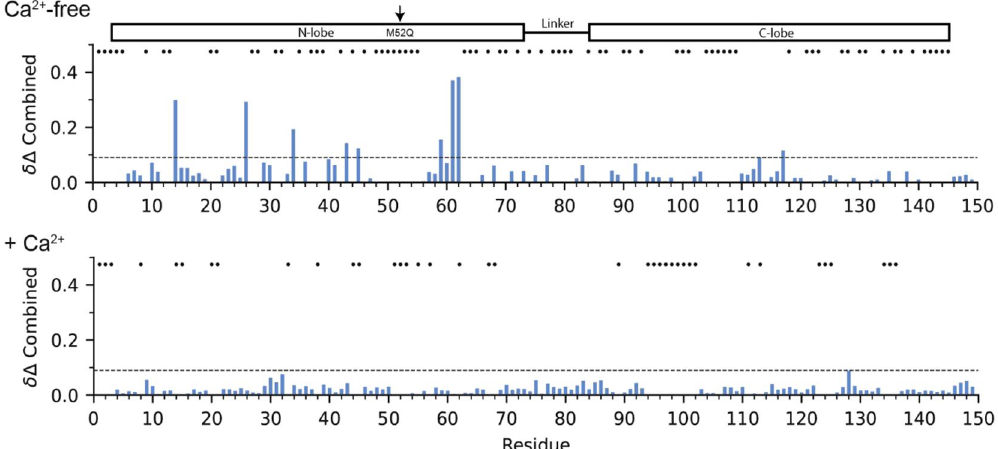
Figure 5. M52Q mutation perturbs CaM’s N-terminal domain in the absence of Ca 2+ . Combined 1 H/ 15 N chemical shift perturbations for M52Q-CaM in the absence and presence of Ca 2+ , relative to WT-CaM based on [ 1 H, 15 N] HSQC spectra. The dashed line represents two standard deviations (0.09) within the data. Asterisks indicate missing peaks or unassigned residues. NMR Spectra were analyzed using NMRFAM-Sparky 46